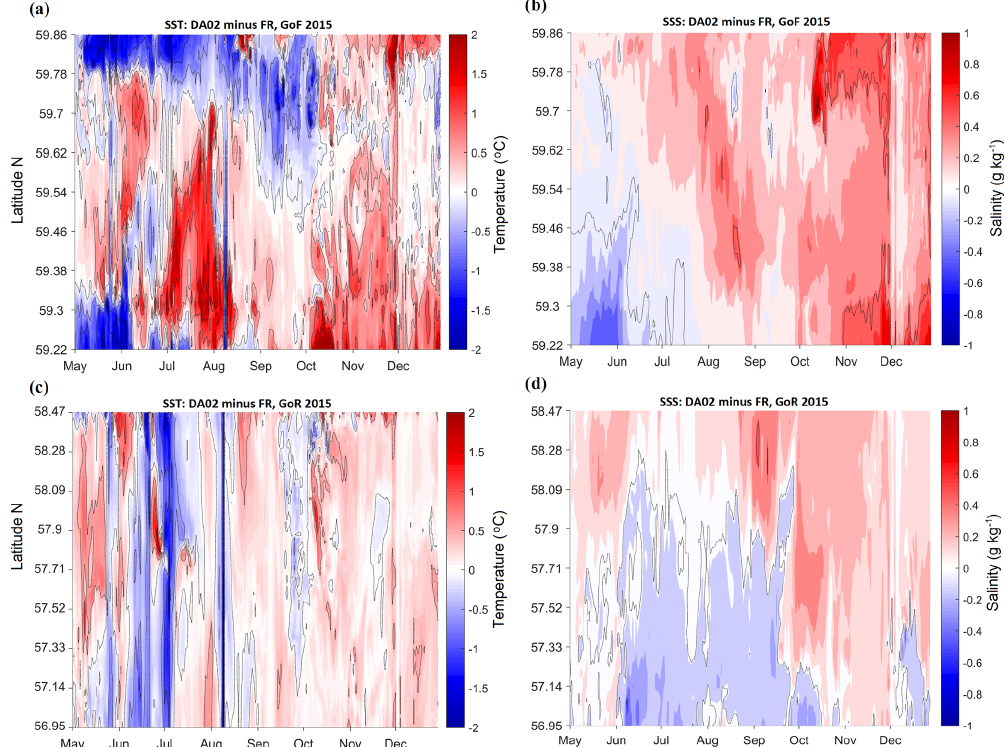
Figure 8. Time (months of 2015) versus latitude (N) contour graph of DA anomalies of SST (a, c) and SSS (b, d) in reference to the control run (FR) without data assimilation at longitudes 23.7166 ◦ E ( a, b , Gulf of Finland) and 23.5333 ◦ E ( c, d , Gulf of Riga); locations shown in Fig. 2a. DA data are given for relaxation time 5d (weight of observations